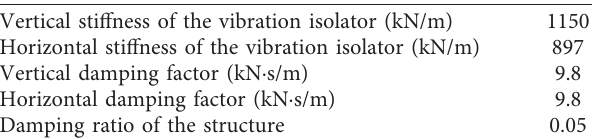
Table 2: Parameters of spring vibration isolator. Vertical stiffness of the vibration isolator (kN/m)